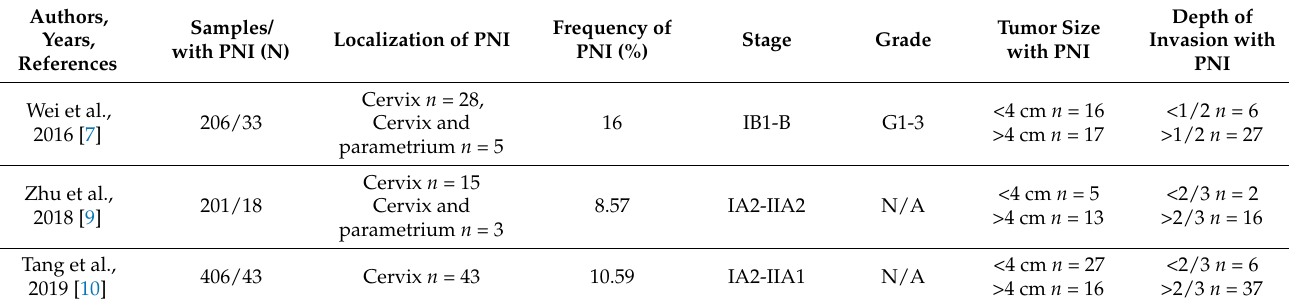
Table 1. The overview of the studies on PNI in